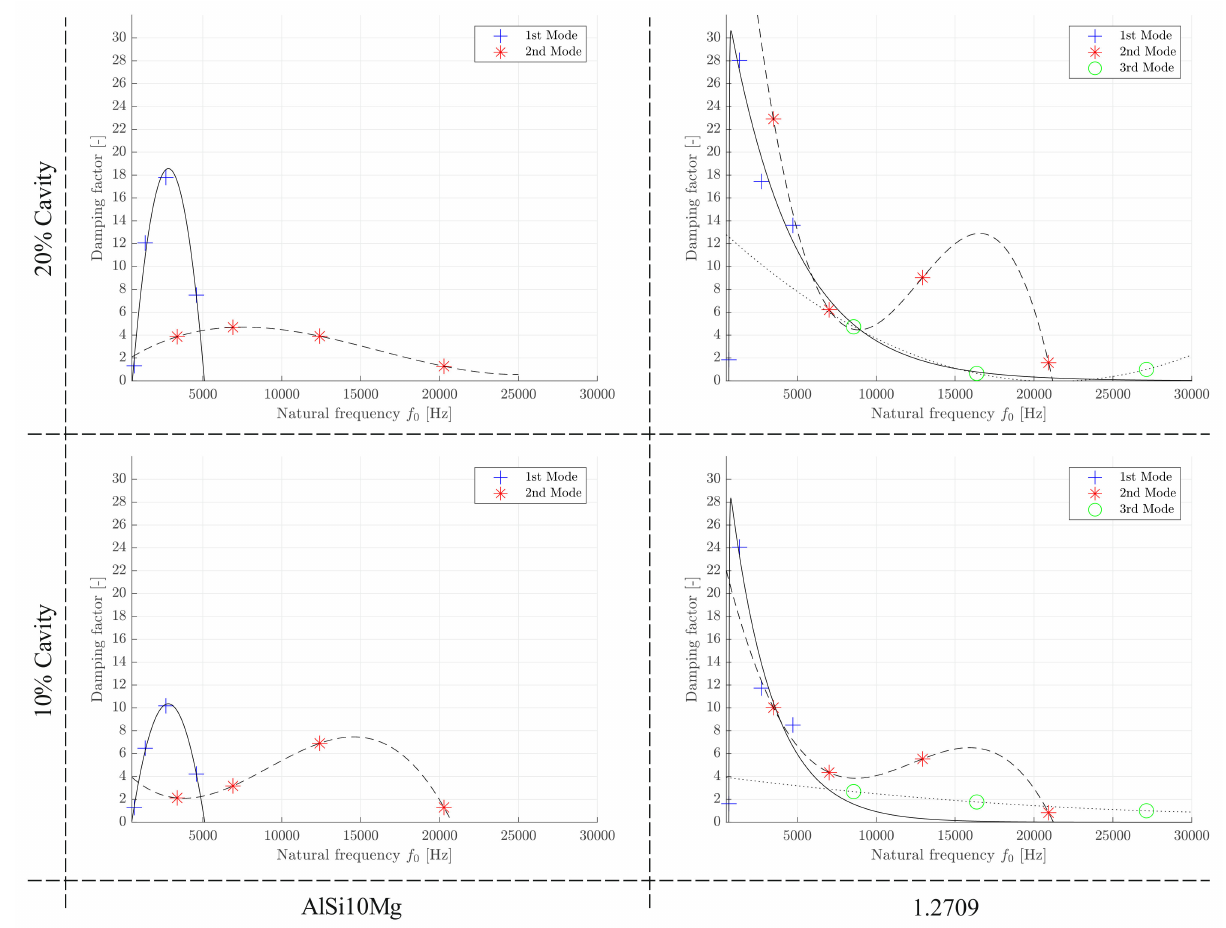
Figure 15. Frequency-dependent damping